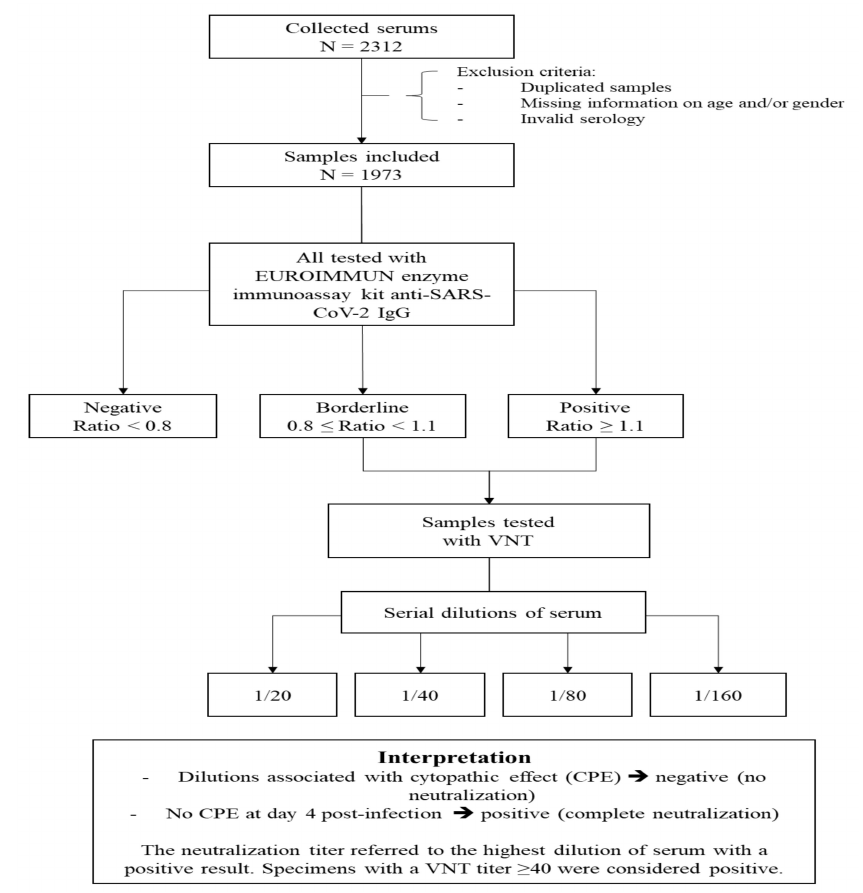
Figure 1. Diagram on sample inclusion and analyses performed. VNT: Virus neutralization